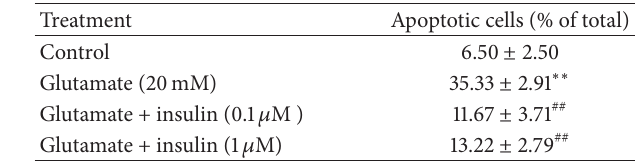
Table 1: Effect of treatments on cell viability in differentiated SH- SY5Y cells.